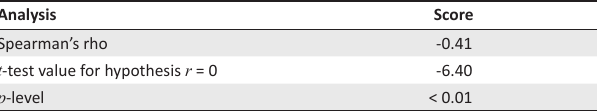
TABLE 3: Linear regression of transformational leadership style and turnover intention.